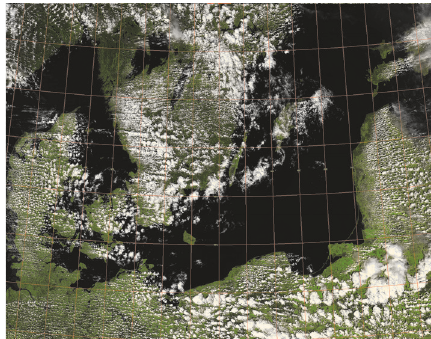
Figure 1: Visual satellite image from the Aqua MODIS satellite from 25 May 2011, 1205